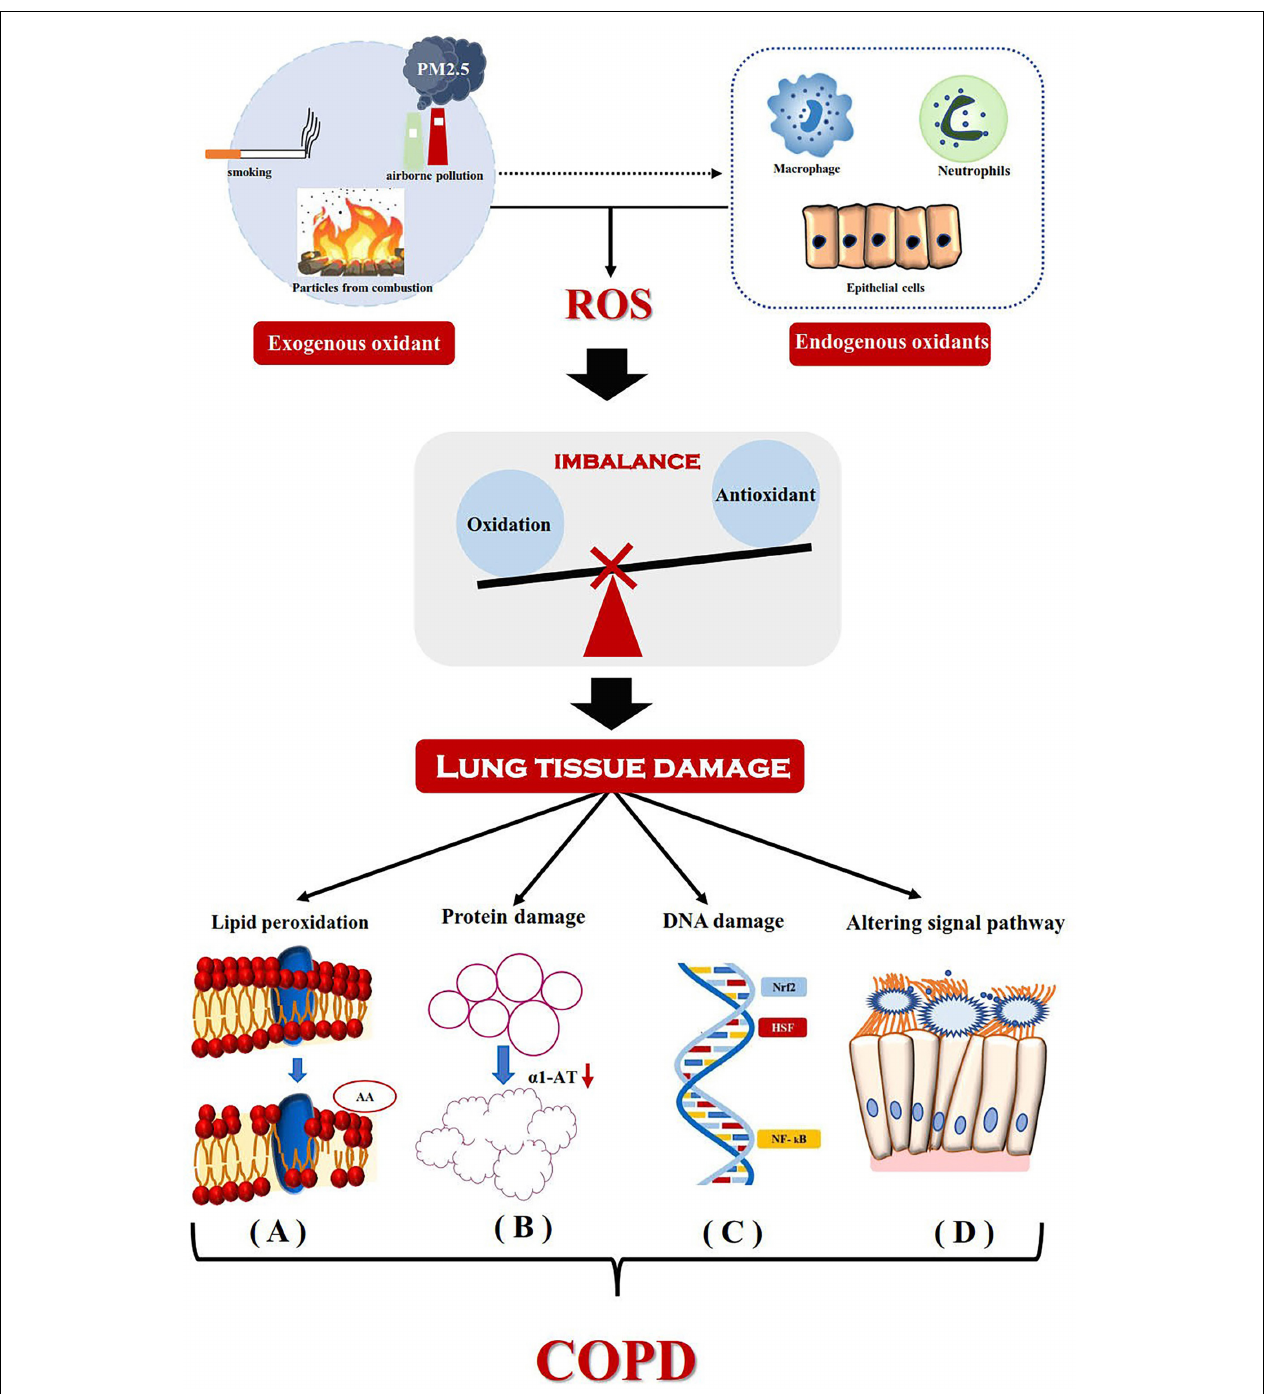
FIGURE 1 | Mechanism for the development of COPD driven by oxidative stress. Exogenous oxidants from the environment and endogenous oxidants (released by activated neutrophils, alveolar macrophages and epithelial cells) lead to the production of reactive oxygen species and cause lung tissue damage. It mainly includes lipid peroxidation, Protein damage, DNA damage and Altering signal pathway. (A) Lipid peroxidation results in the hydrolysis of phospholipids in the cell membrane and changes in the structure and permeability of the cell membrane. Arachidonic acid produced by hydrolysis of phosphoric acid molecules, its metabolites thromboxane, prostaglandin E and leukotriene C4 are involved in the inflammatory process. (B) The inactivation of α 1-AT breaks the balance between protease and anti-protease, which do great damage to elastin and eventually leads to emphysema. (C) Gene expression of inflammatory mediators induced by DNA damage. (D) Oxidative stress changes TNF- α -mediated signaling pathway, which leads to increased mucus secretion and ciliated cell dysfunction. ROS, reactive oxygen species; AA, arachidonic acid; α 1-AT, alpha-1-antitrypsin; Nrf2, nuclear factor erythroid-2-related factor2; HSF, heat shock transcription factor; NF- kB, Nuclear Factor- κ